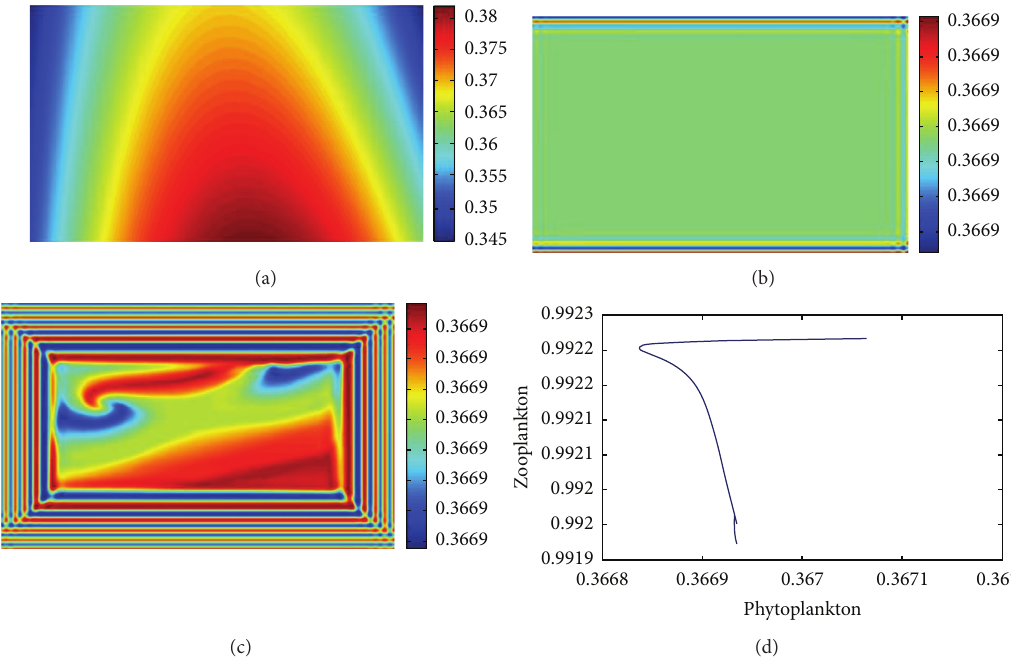
Figure 3: Spatiotemporal dynamics of model (3) where 𝑏 = 1.2 . The number of iterations are as follows (a) 1 , (b) 200 , and (c) 3000 . (d) The phase diagram.